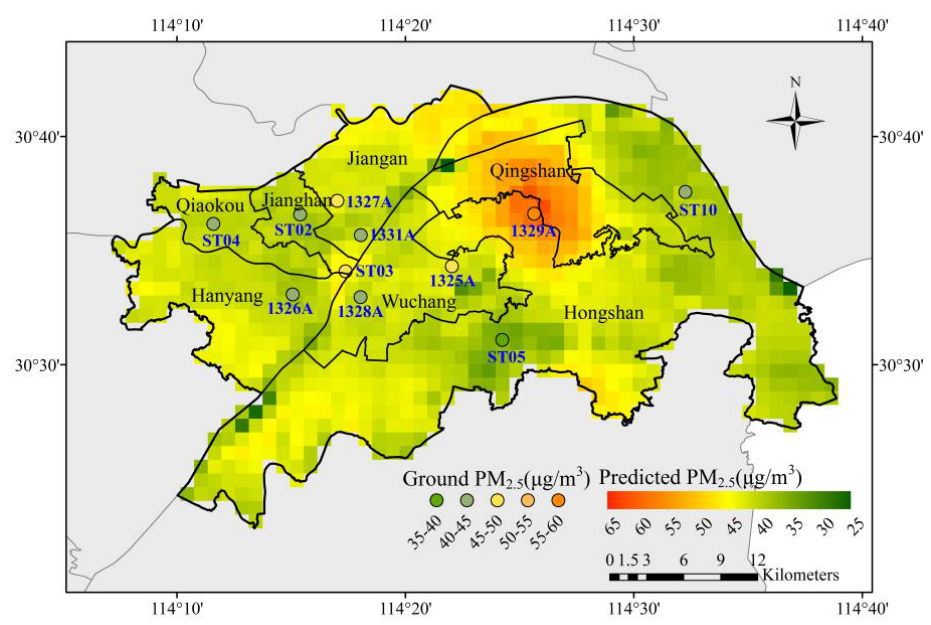
Figure 7. The spatial distribution of the average concentration of estimated PM 2.5 and the average PM 2.5 concentration for each monitoring station during the study period. (24 January 2018 to 31 July, 2018).